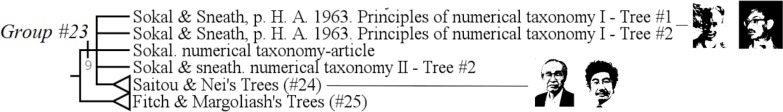
Subtree showing the group #23 (called “Theoricians of Phenetics”).